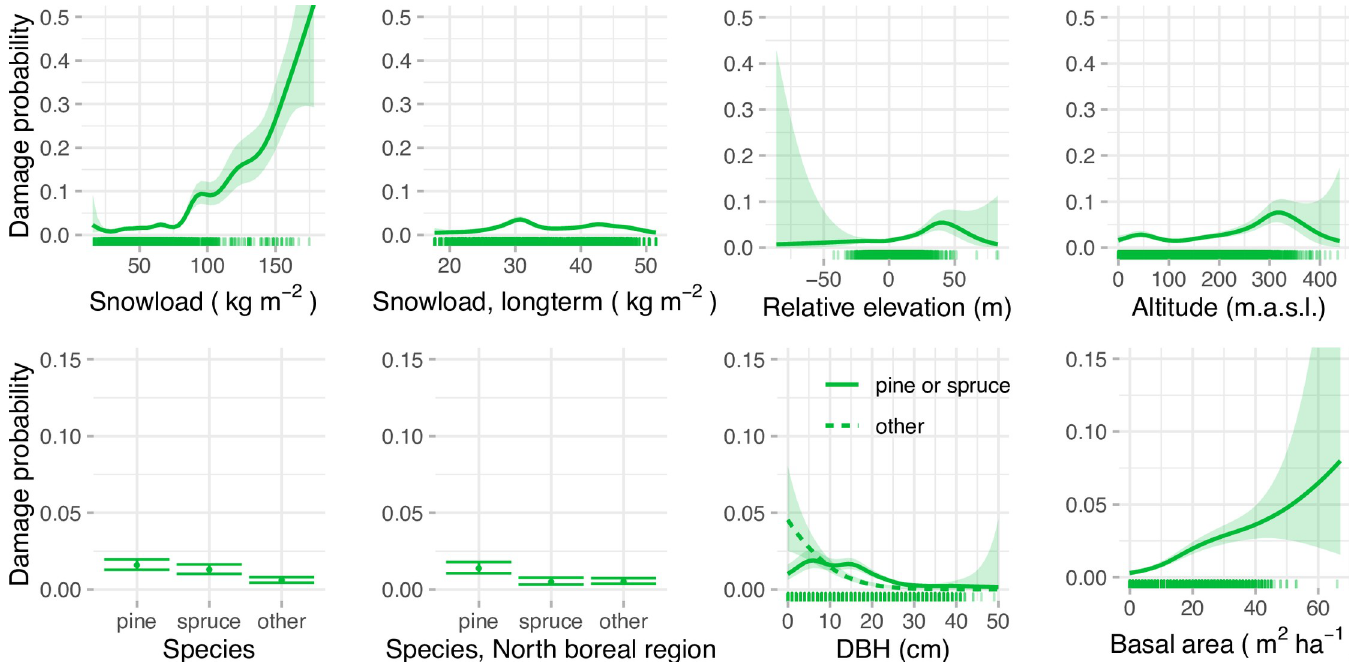
Fig 4. Effects plots for predictors in the full GAM model. Note different y-axis limits in abiotic variables (upper row) and the forest variables (lower row). The rug showing the distribution of data points is a random subset of 10 000 plots from the original data.